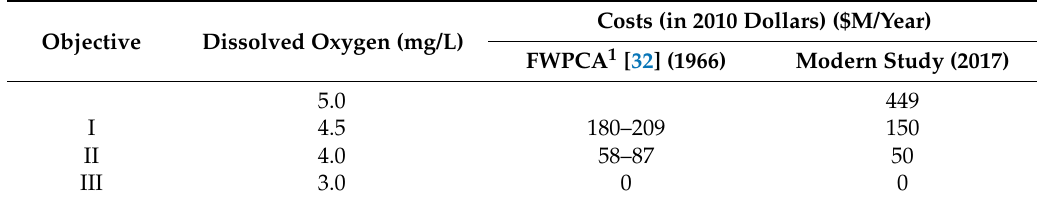
Table 9. Comparison of costs to meet water quality criteria along the Delaware River.